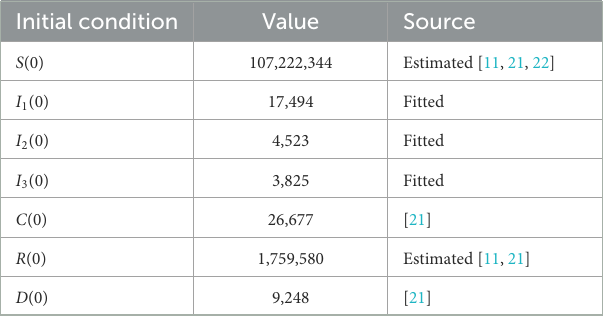
TABLE 3 Initial conditions used in the